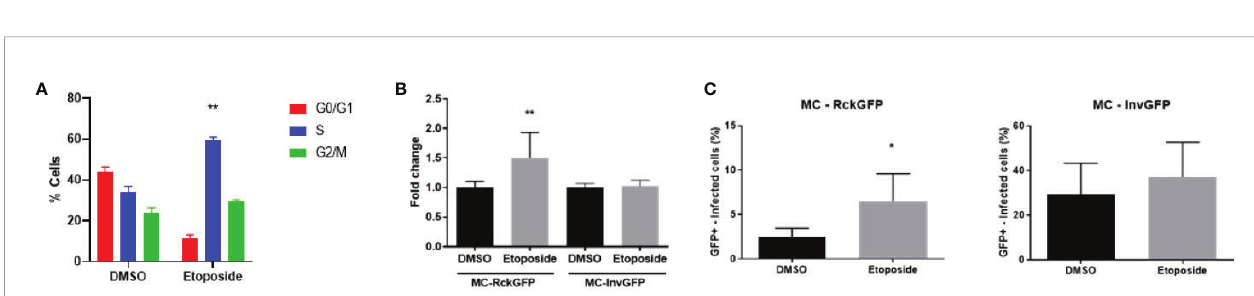
FIGURE 7 | DNA damage and checkpoint responses facilitate Rck-mediated internalization. HCT116 cells were treated for 16 h with either etoposide at 10 µM or DMSO as a control and then infected with MC-RckGFP or MC-Inv GFPGFP strain for 1 h at a MOI of 10. (A) Before infection, cell cycle was analyzed on DMSO or etoposide treated cells. Results are means ± SD of the percentage of cells in the different phases of the cell cycle. (B) The percentage of internalized bacteria was determined as detailed in Materials and Methods and normalized to values obtained with DMSO pretreatment, set at 1. Results are the mean ± SD obtained from three independent experiments with two infected wells per experiment. (C) The percentage of infected cells was determined using fl ow cytometry according to GFP fl uorescence. Results are the mean ± SD obtained from three independent experiments with 30,000 events acquired per experiment. Data were compared using a Mann-Whitney test (*p < 0.05; **p < 0.01; DMSO vs.